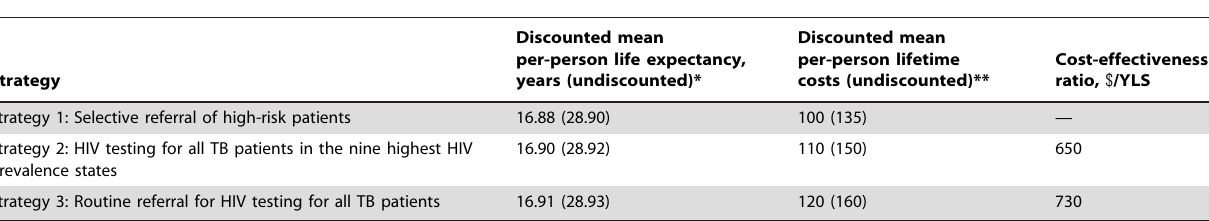
Table 6. Incremental cost-effectiveness of alternative HIV testing strategies for TB patients in India.